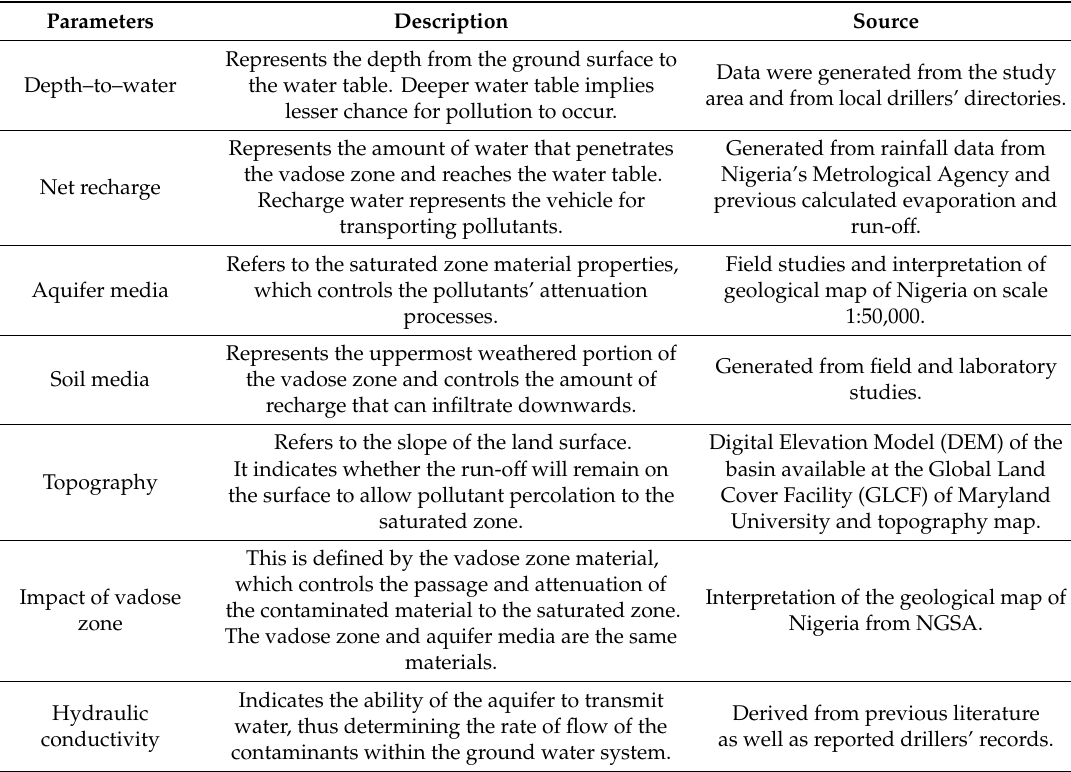
Table 1. Sources of data employed in the DRASTIC